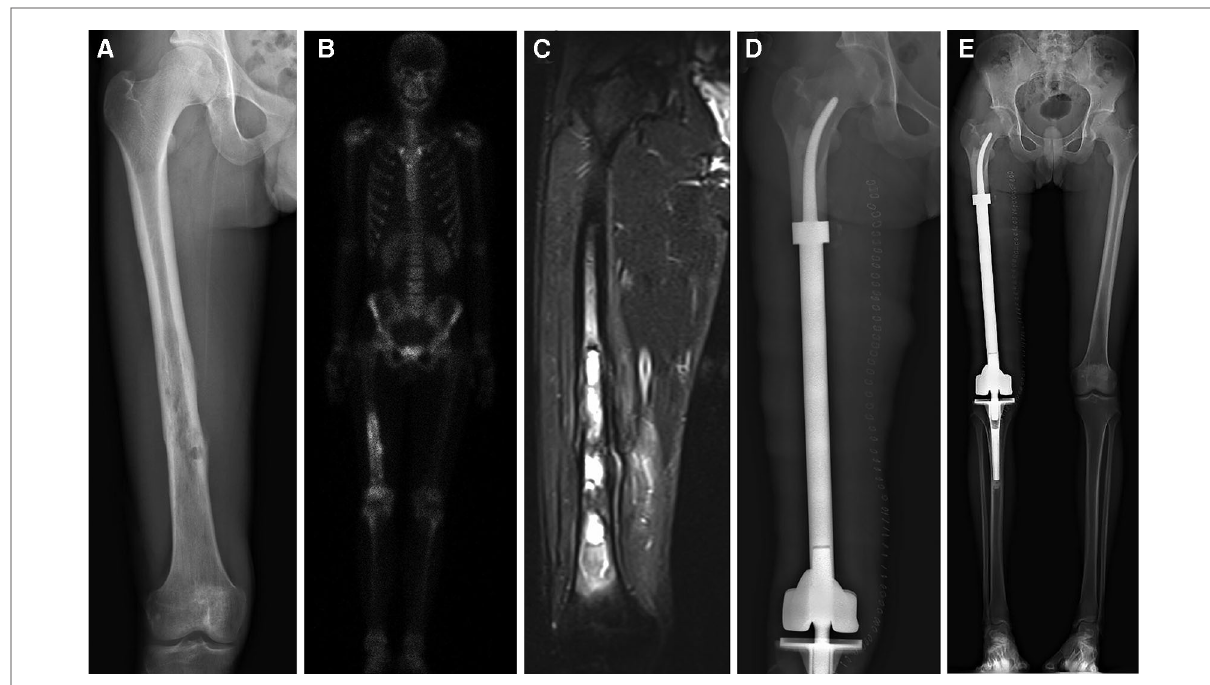
FIGURE 2 All patients underwent en bloc tumor resection followed by reconstruction with the customized cemented femoral endoprosthesis with an intra- neck curved stem. ( A ) Anteroposterior radiograph of the right femur of a patient with a distal femoral myo fi broblastic sarcoma. ( B ) Single-photon emission whole-body Computed tomography image. ( C ) Magnetic resonance image of the patient ’ s right upper leg. ( D ) Postoperative radiograph of the femur. ( E ) Full-length x-ray fi lms of lower extremities in anteroposterior view at 7 days after